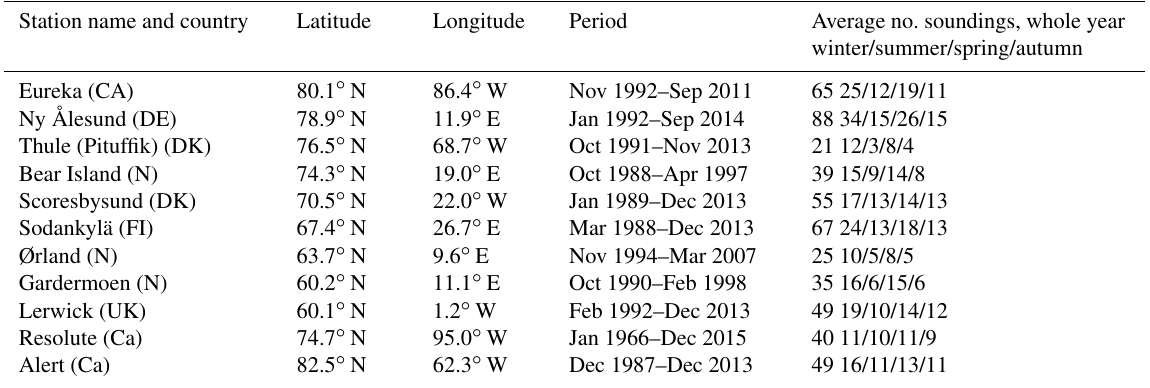
Table 1. The stations included in the study. Results from Resolute and Alert are shown in the Supplement. Station name and country Latitude Longitude Period Average no. soundings, whole